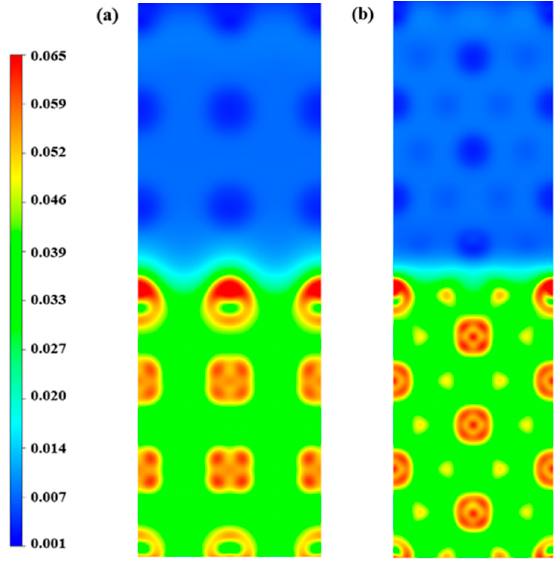
Figure 4. The charge densities of ( a ) Li(100)/Ta(100) and ( b ) Li(110)/Ta(110) bilayers (in e/Bohr 3 ). The upper and lower half-part is the Li, and Ta layer, respectively.